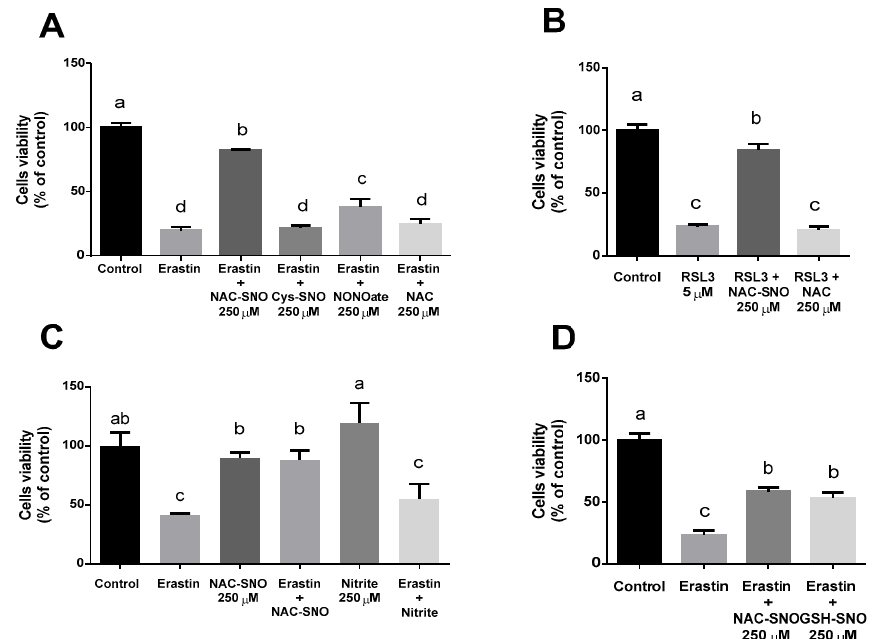
Figure 3. The effect of NO donors on cell viability in ferroptosis. Cell viability was measured by MTT assay of AML12 cells treated with ( A ) 20 µ M Erastin and 250 µ M NAC-SNO, S-nitroso-cysteine (cys-SNO), NONOate, and NAC for 24 h. ( B ) 5 µ M RSL3 and 250 µ M NAC-SNO and NAC for 6 h. ( C ) 20 µ M Erastin with or without 250 µ M nitrite and S-nitroso-N-acetylcysteine (NAC-SNO) for 24 h. ( D ) 20 µ M Erastin and 250 µ M NAC-SNO and S-nitroso-glutathione (SNO-GSH). Means with different letters are statistically different ( p <